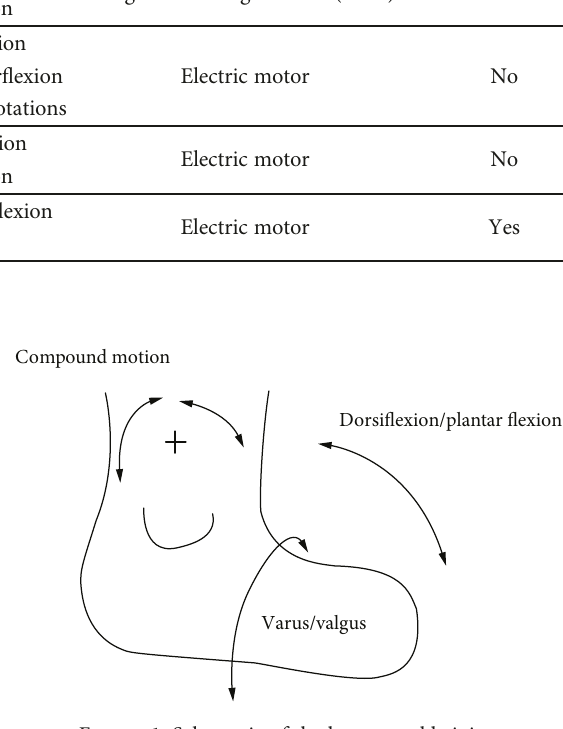
Figure 1: Schematic of the human ankle